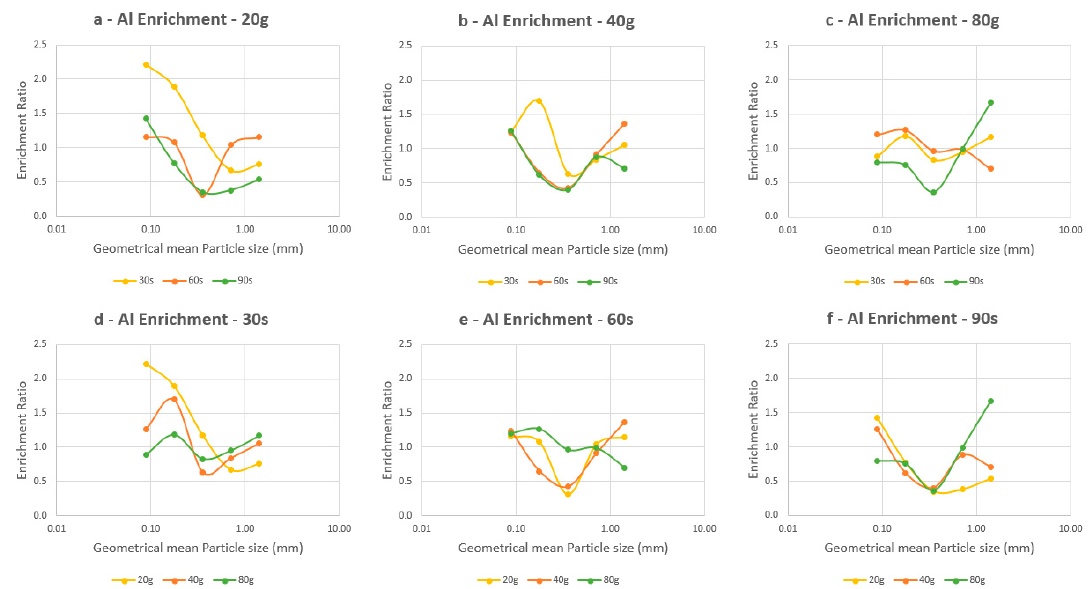
Figure 8. Al enrichment ratio after hammer milling as a function of feed mass, milling time and particle size. Feed Size 1–2 mm. ( a ) 20 g feed, ( b ) 40 g feed ( c ) 80 g feed, ( d ) 30 s milling time, ( e ) 60 s milling time, and ( f ) 90 s milling time. Experimental data points are connected with lines for the purpose of visual aid only.